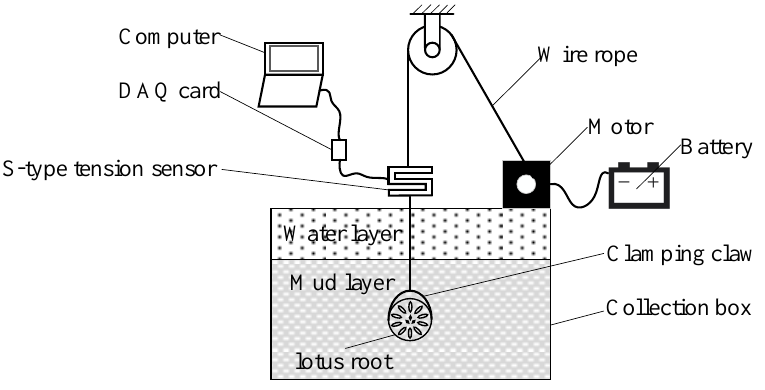
Figure 3. Sketch map of the testing platform.